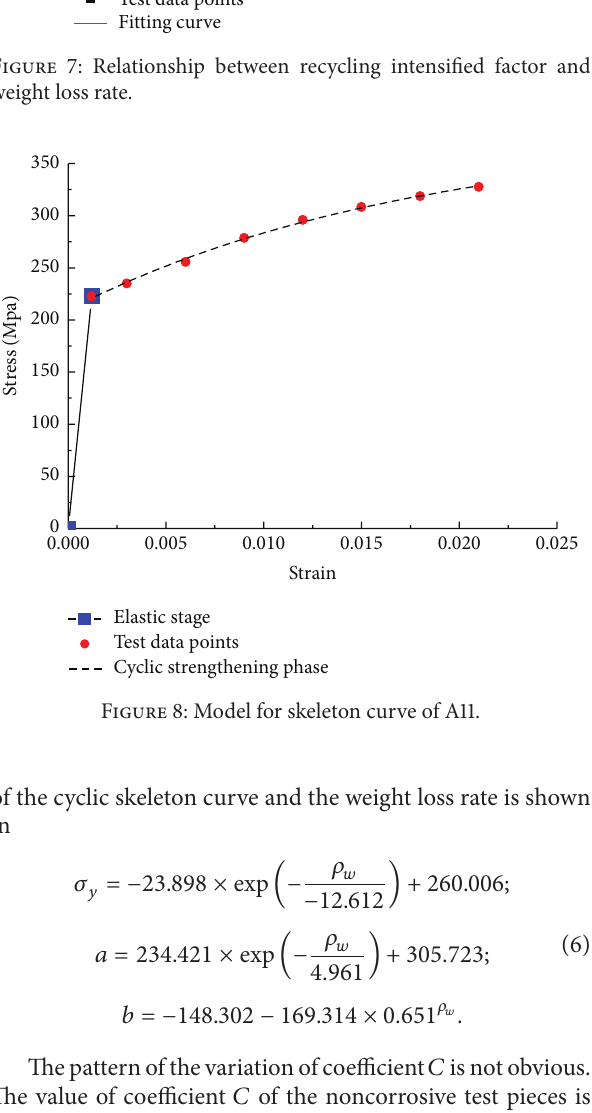
Figure 9: Reloading curve